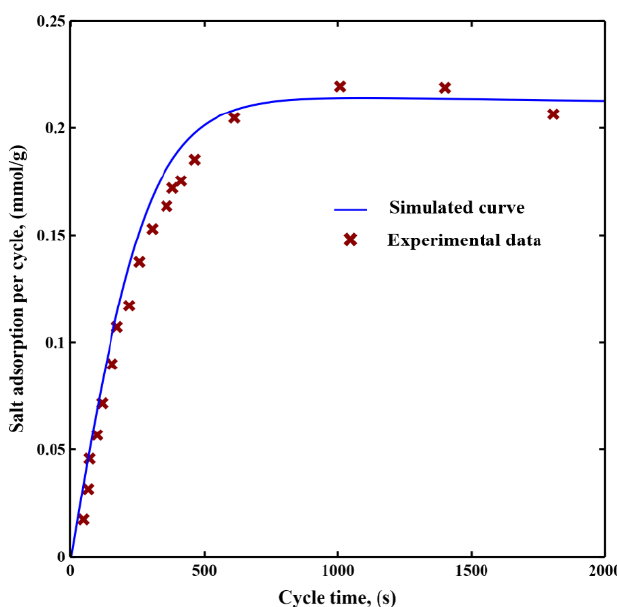
Figure 3. Simulated salt adsorption per cycle curve with this model and experimental data from ref. [25].